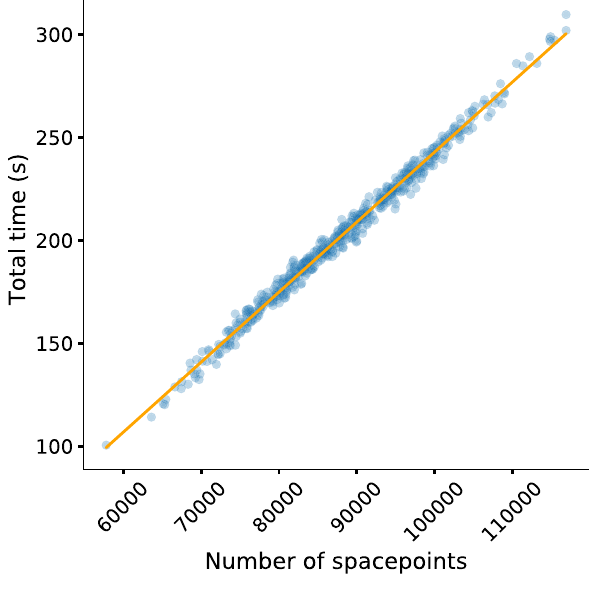
by this function, normalized to have a mean of weight =